Question: Identify the chart type used in this figure.
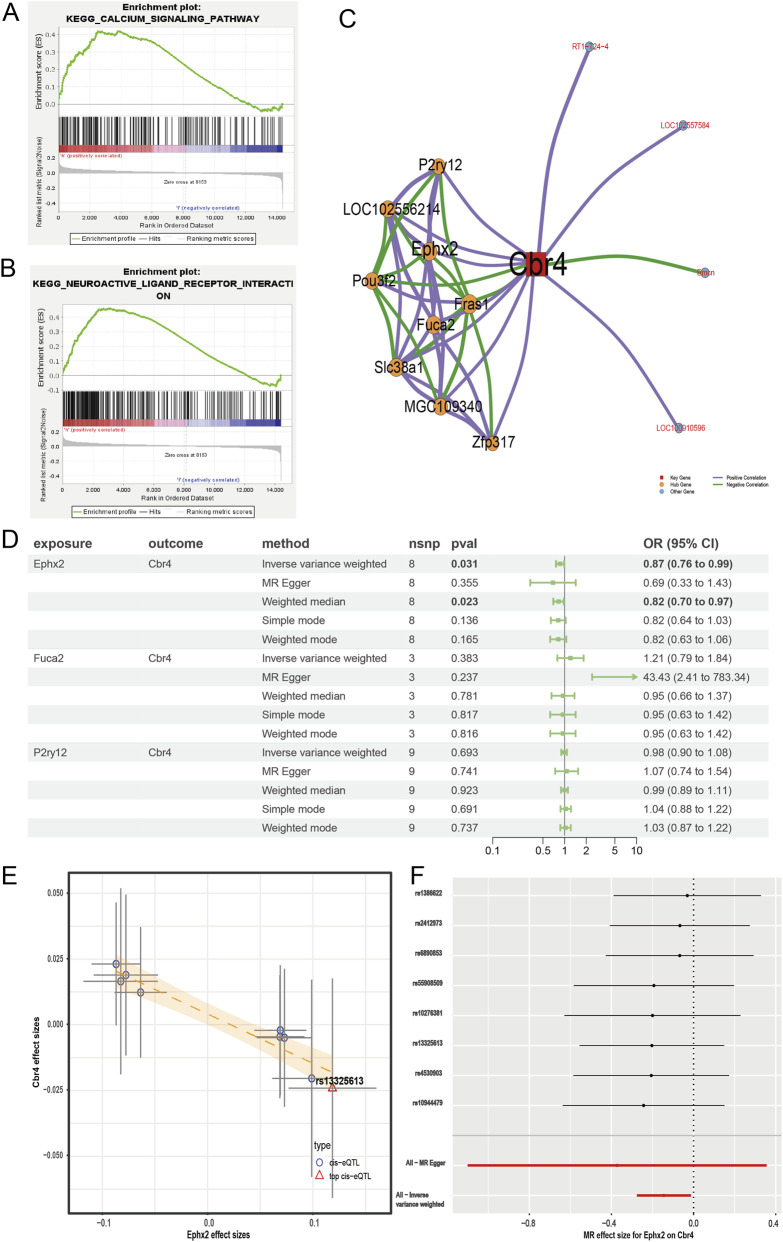
Answer: forest